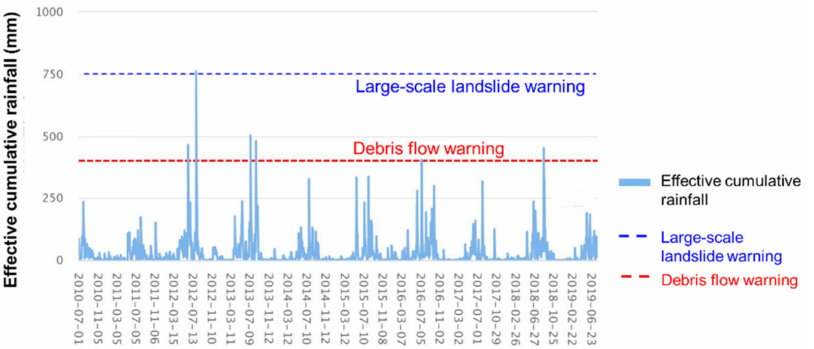
Figure 16. Review of possible alert issuance scenarios for debris flow and large-scale